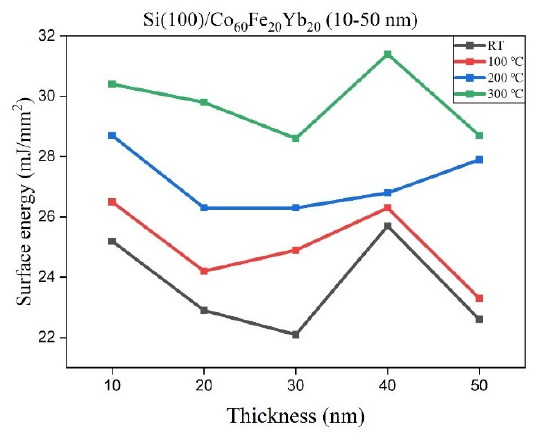
Figure 6. Surface energy of CoFeYb films.